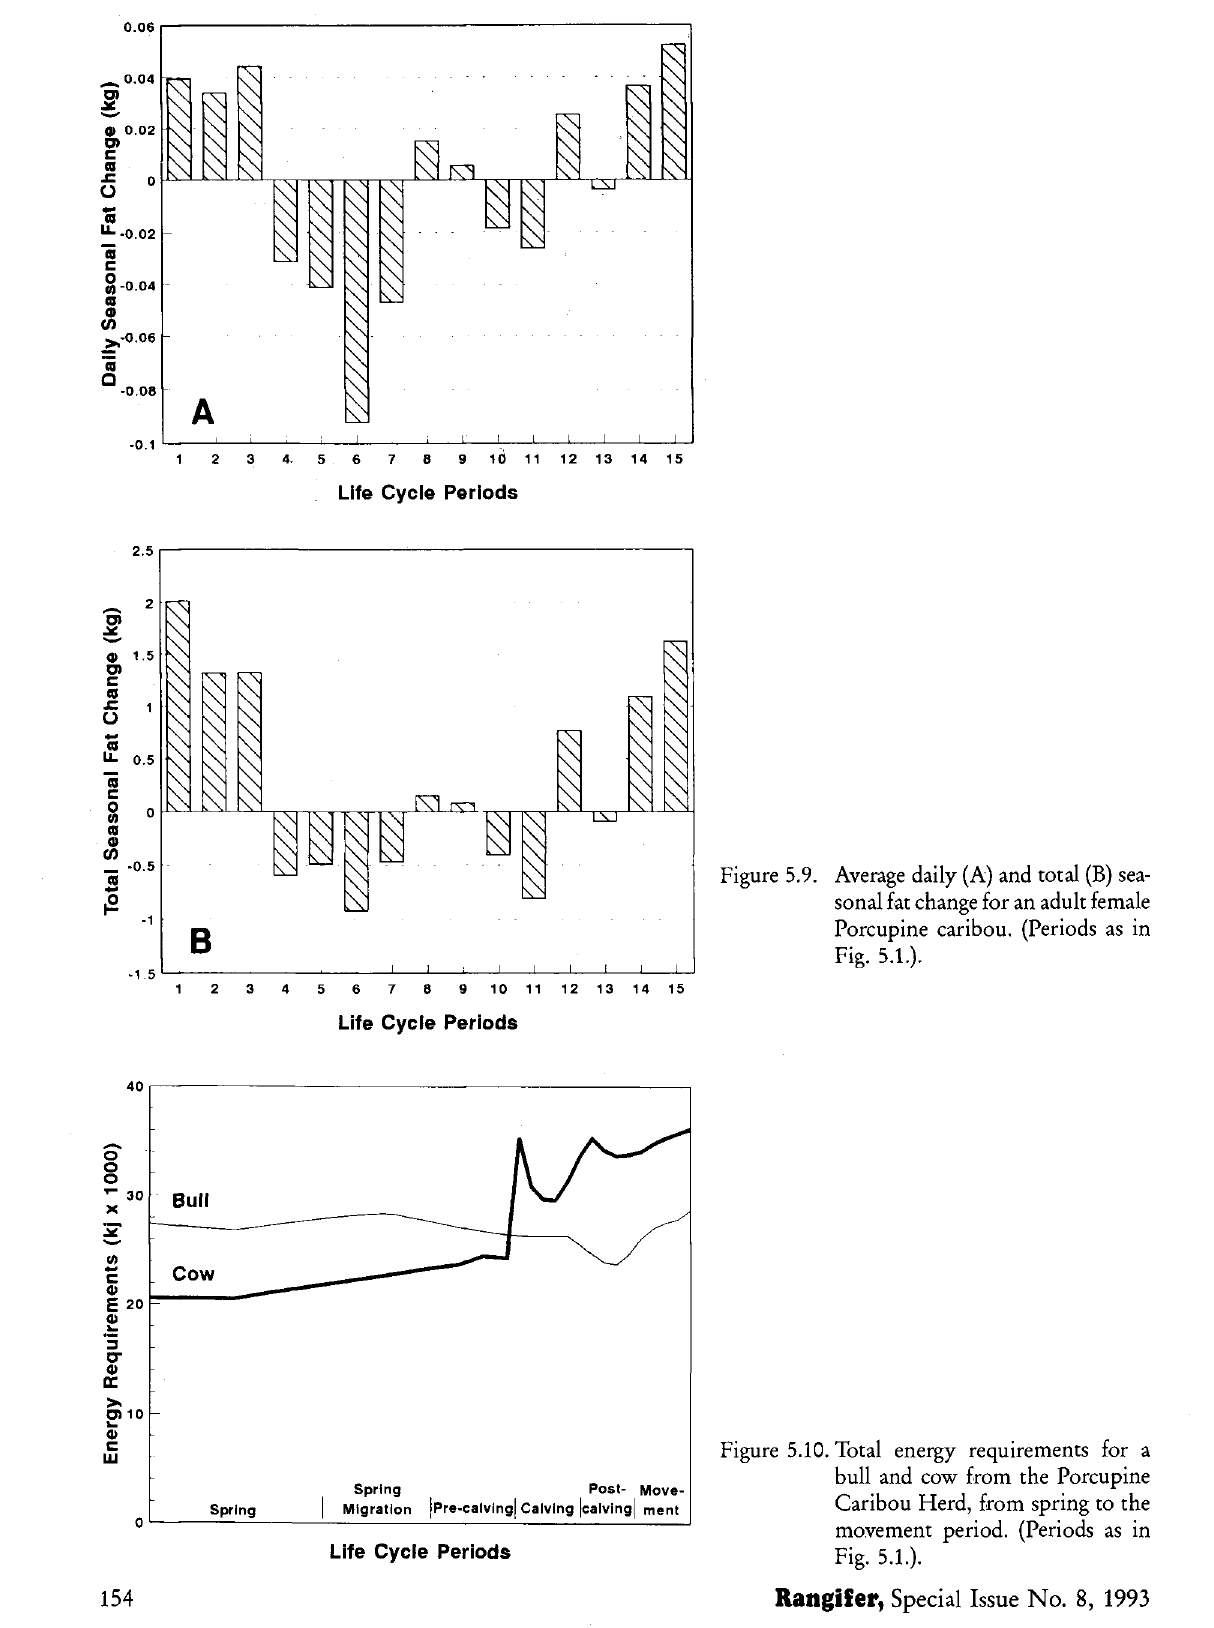
Figure 5.10. Total energy requirements for a bull and cow from the Porcupine Caribou Herd, from spring to the movement period. (Periods as in Fig.